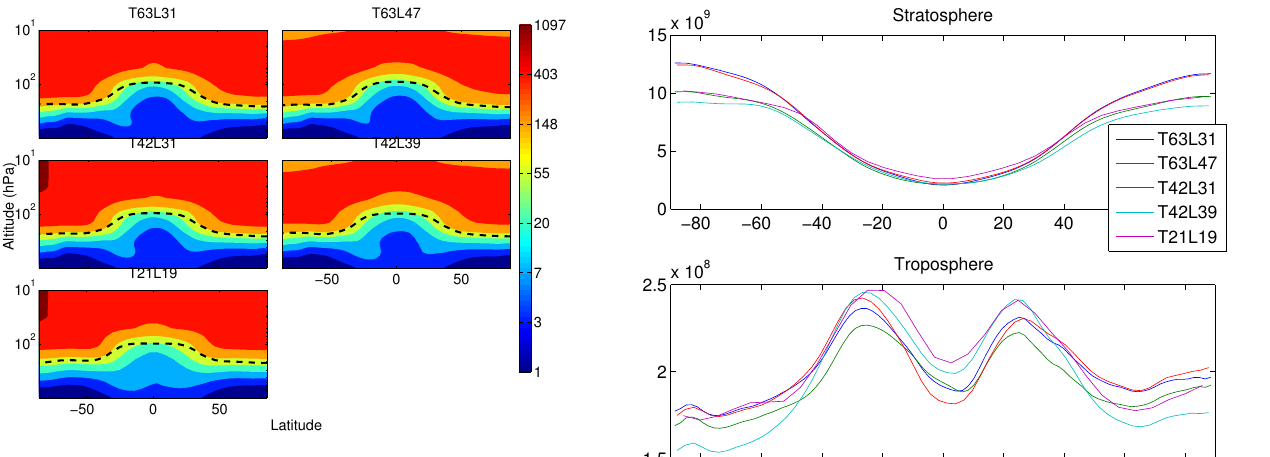
Fig. 7. Scatter plot of modelled versus observed 1998–2002 mean 7 Be and 210 Pb surface air concentrations (mBq m − 3 STP) and de- Fig. 9. Zonal mean stratospheric and tropospheric column density position flux of 7 Be atoms (100 m − 2 s − 1 ) and 210 Pb atoms (1000 of 10 Be atoms (concentration integrated over the atmospheric col- m − 2 s − 1 ) with different model resolutions. Correlation coefficients umn m − 2 ) with different model resolutions. and root mean squared errors are also shown for each resolution, in the order indicated in the legend.